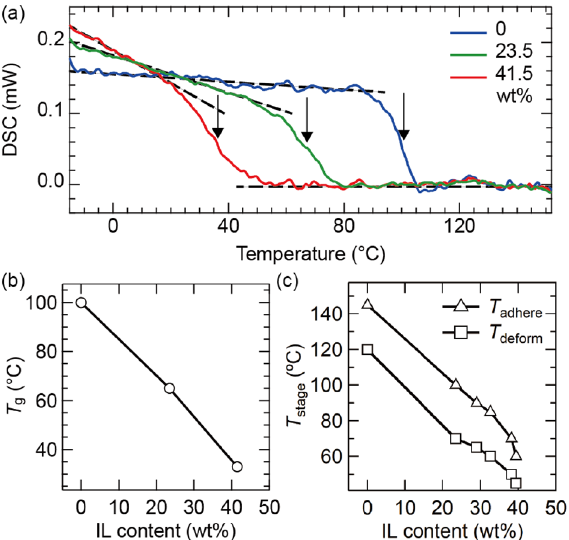
Figure 1. ( a ) Differential scanning calorimetry curves of Elvacite2552C-IL compounds for varying IL contents (blue) 0, (green) 23.5, and (red) 41.5 wt%. ( b ) Glass transition temperature (cid:31) T g (cid:30) of Elvacite2552C-IL compounds as a function of the IL content. ( c ) Stage temperature (cid:31) T stage (cid:30) at which the Elvacite2552C-IL compounds